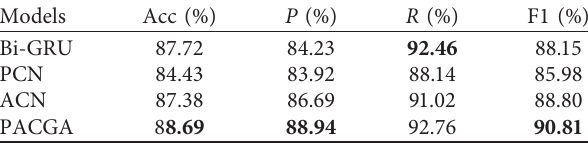
Table 4: Analysis of the PACGA model on Puns.